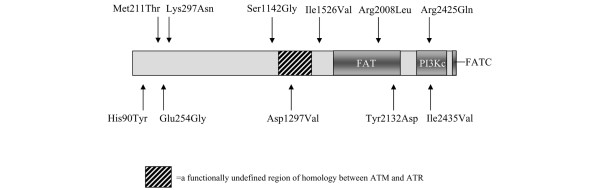
Structure of ATR and the location of observed amino acid changes.